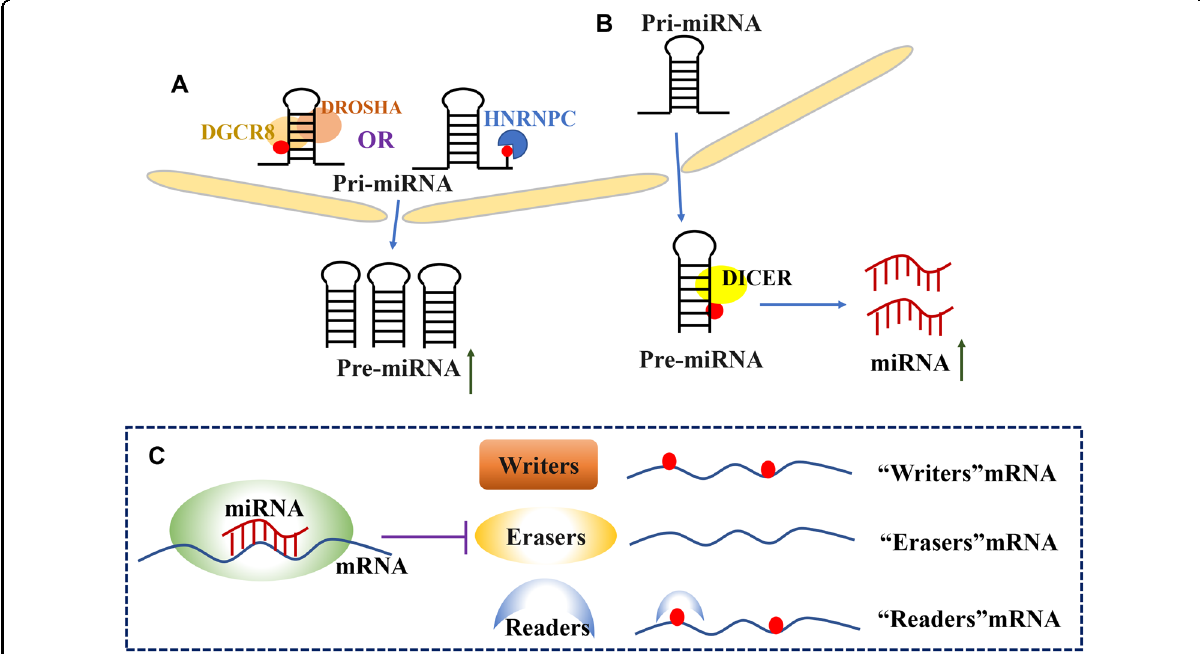
Fig. 2 Mutual regulation between m6A and miRNAs. A In the nucleus, the intranuclear enzyme Drosha and DGCR8 cleave primary microRNA (pri- miRNA) to precursor microRNA (pre-miRNA). m6A modi fi cations helps to recruit DGCR8 to target pri- miRNA and promote the formation of pre- miRNA. Meanwhile, HNRNPC can directly recognize the m6A sites. B In the cytoplasm, Dicer cleaves pre-miRNAs transported to the cytoplasm into mature miRNAs. C miRNAs regulate the expression of m6A regulatory proteins. miRNAs regulate the expression of mRNAs encoding for writers, erasers, and